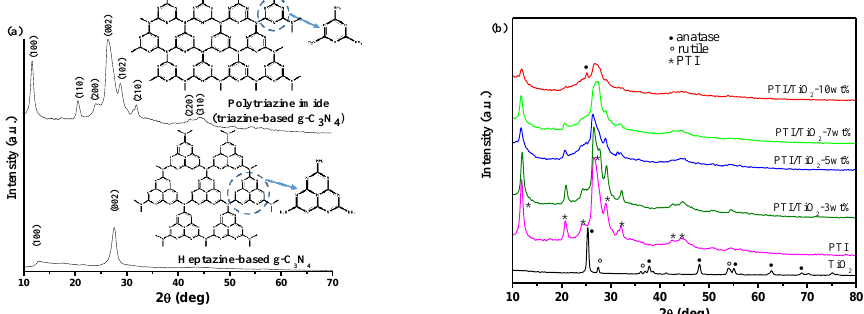
Figure 1. ( a ) XRD patterns of poly(triazine imide) (PTI), g-C 3 N 4 , ( b ) XRD patterns of TiO 2 , PTI, PTI/TiO 2 heterojunction.